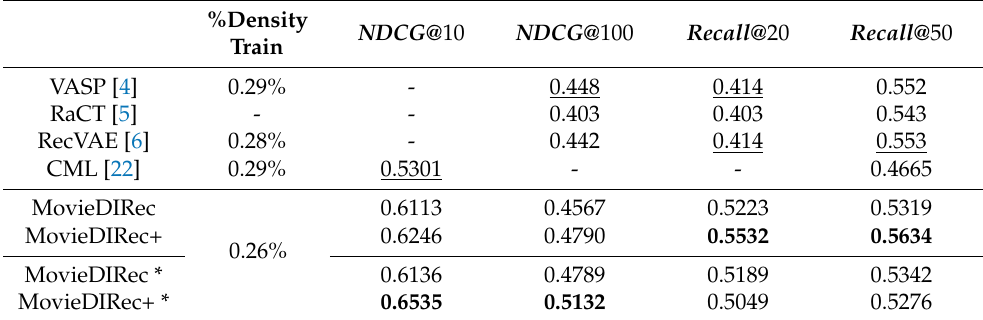
Table 2. Comparison table for each metric. * is a symbol for models that were trained with Drafted-